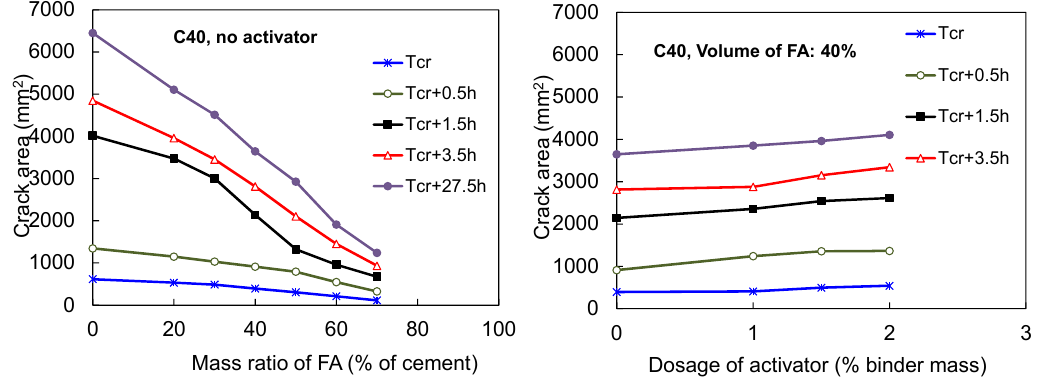
Figure 11. Effects of the mass of FA and the dosage of AC on the cracked area of FACs.